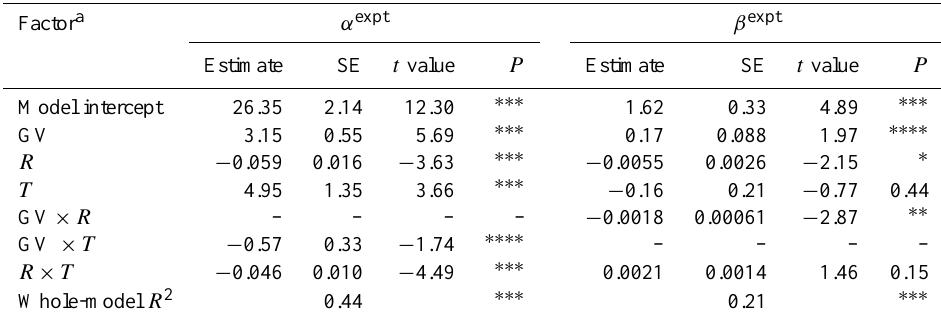
Table 1. The effects of experiment-specific variance of model parameters and climate on individual-level coefficients (i.e. α expt Fig. 4a).